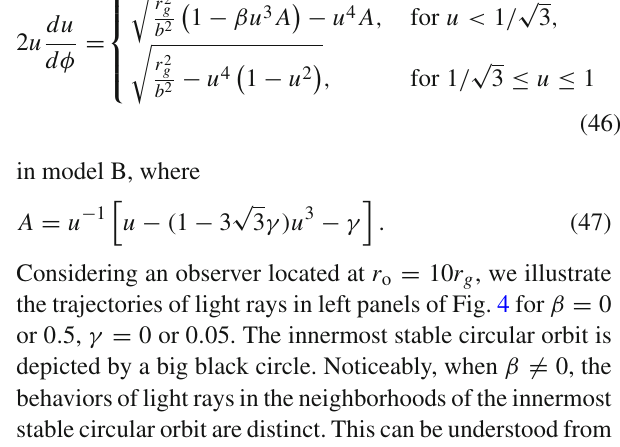
Fig. 3 Influences of the plasma on the radius of the black hole shadow for model B in Sect. 5. Black asterisks represent the uncorrected radius according to Eq. (42), red diamonds denote the refractive corrections accordingtoEq.(43),andbluecirclesmarkthegravitationalcorrections according to Eq. (44). Data in Table 1 have been used